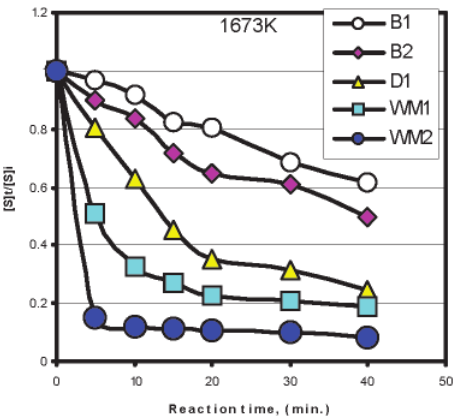
Fig. 4: Desulphurization using fluxes made from different